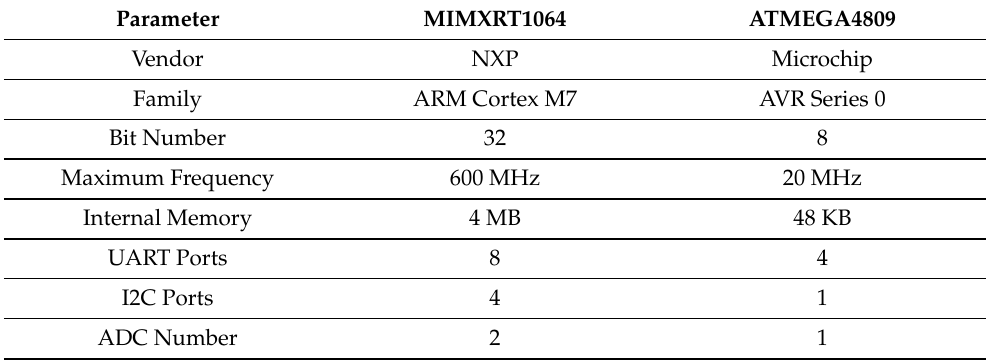
Table 2. Microcontroller specifications supported by the software development framework.